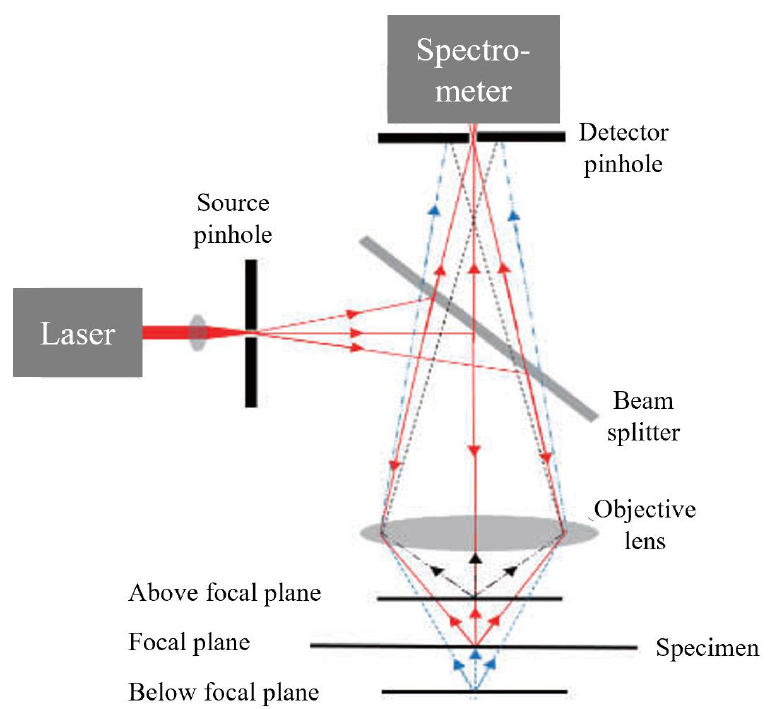
Figure 2. Schematic setup of a confocal Raman microscope [9].